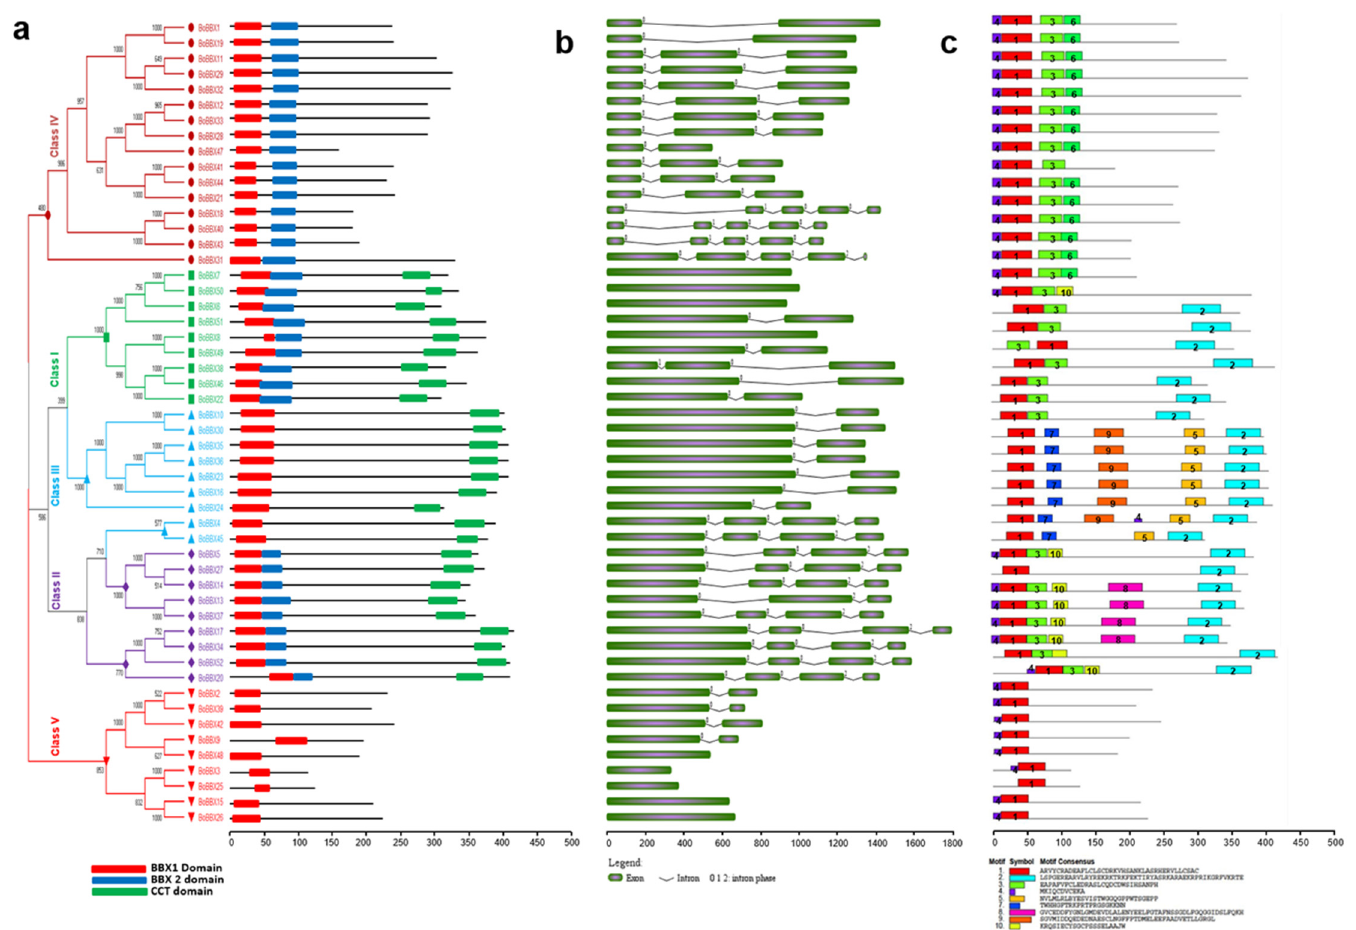
Figure 5. Brassica oleracea B-box gene structures ( a ), motifs ( b ), and conserved domains ( c ). The domain architecture of the B-box genes is presented in panel a. Exons are represented by colored boxes, whereas introns are indicated by gray lines ( b ). Colored boxes indicate conserved motifs and gray lines represent non-conserved sequences. The motif lengths in each protein are presented proportionally. Classes I–V represent different groups of B-box family members in B. oleracea.